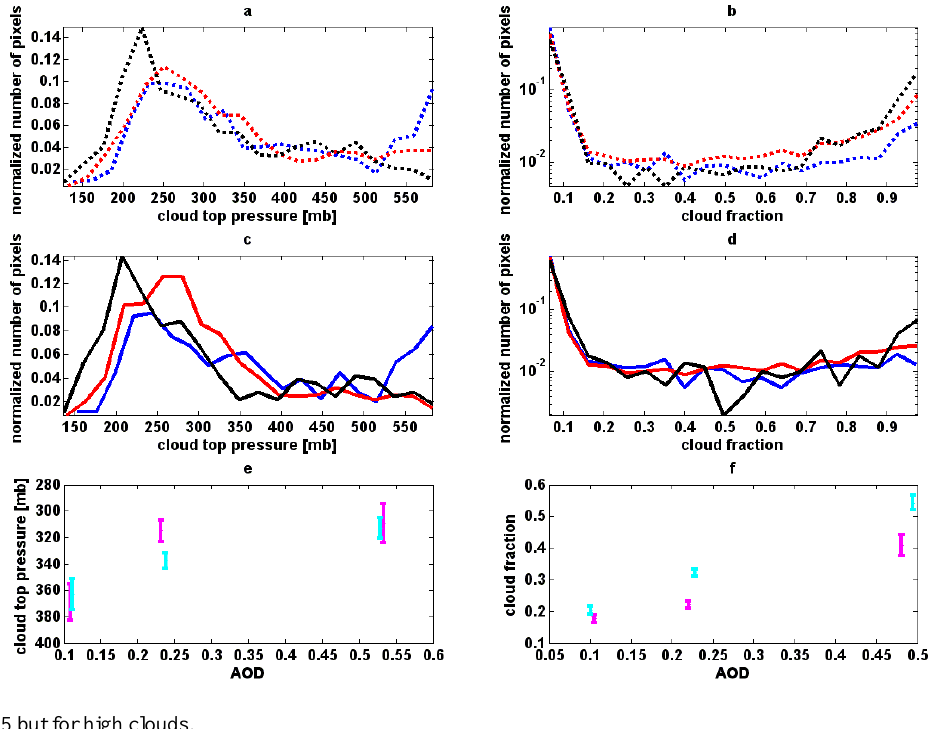
Fig. 6. As in Fig. 5 but for high clouds.